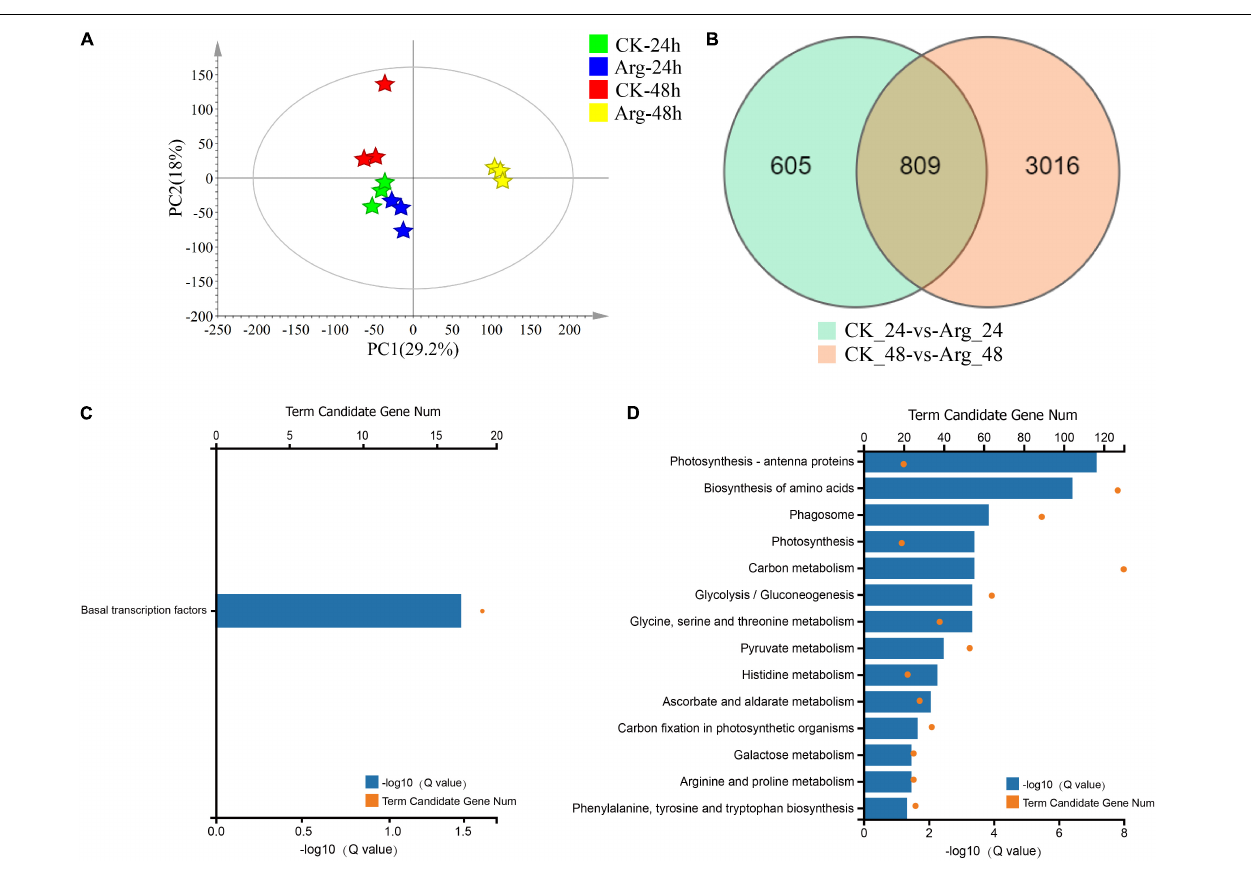
FIGURE 3 | Overview of Arg-induced transcriptomic changes of G. lemaneiformis under HT stress. (A) Principal component analysis (PCA); (B) number of differentially expressed genes (DEGs) between different groups; (C) significantly enriched KEGG pathway at 24 h and (D) significantly enriched KEGG pathway at 48 h. KEGG, Kyoto Encyclopedia of Genes and